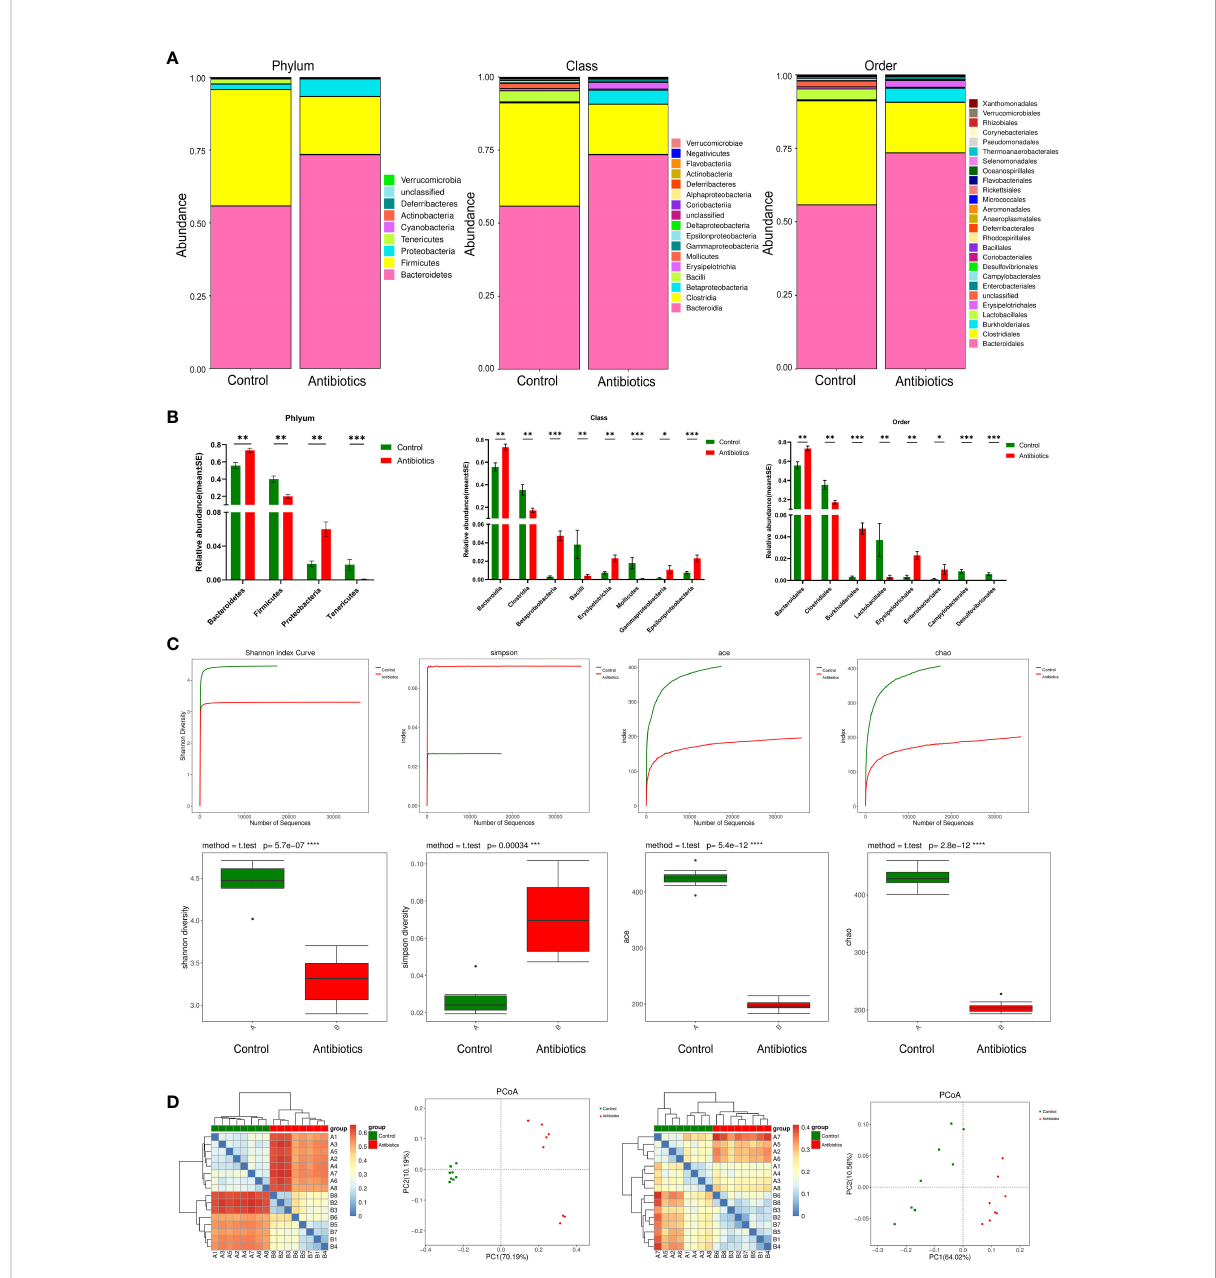
FIGURE 2 antibiotics altered gut microbiota. (A) Comparison of two groups of gut microbiota. (B) Difference of gut microbiota between two groups. (C) Alpha Diversity Analysis. (D) Beta diversity analysis based on evolutionary relationships, matrix heat map and POCA analysis of Weightedunifrac and unweightedunifrac. *p<0.05, **p<0.01, ***p<0.001,